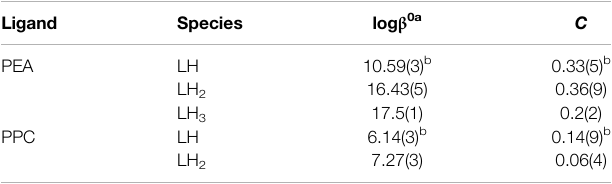
TABLE 3 | Protonation constants at in fi nite dilution and parameters for the dependence on ionic strength Eq. 5 , of PEA and PPC species at t = 25 ° C in NaCl.